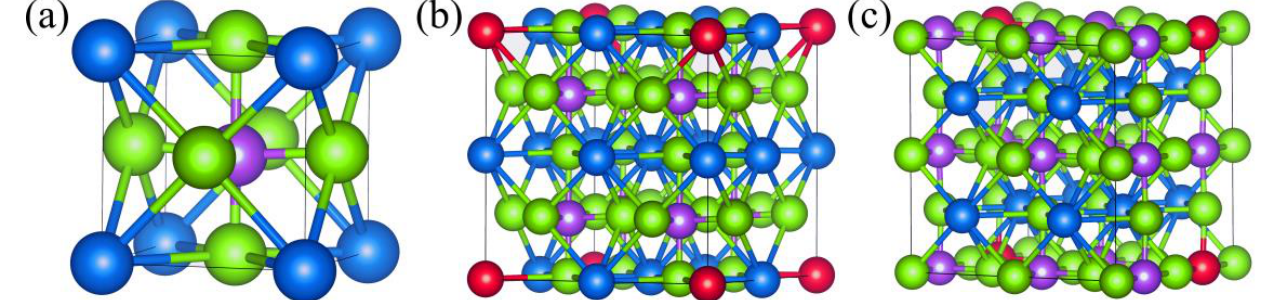
Figure 1. Crystal structures of ( a ) pure BaTiO 3 , ( b ) Ba site substitution, and ( c ) Ti site substitution. Ba is dark blue, Ti is purple, O is light green, and Ce is red.